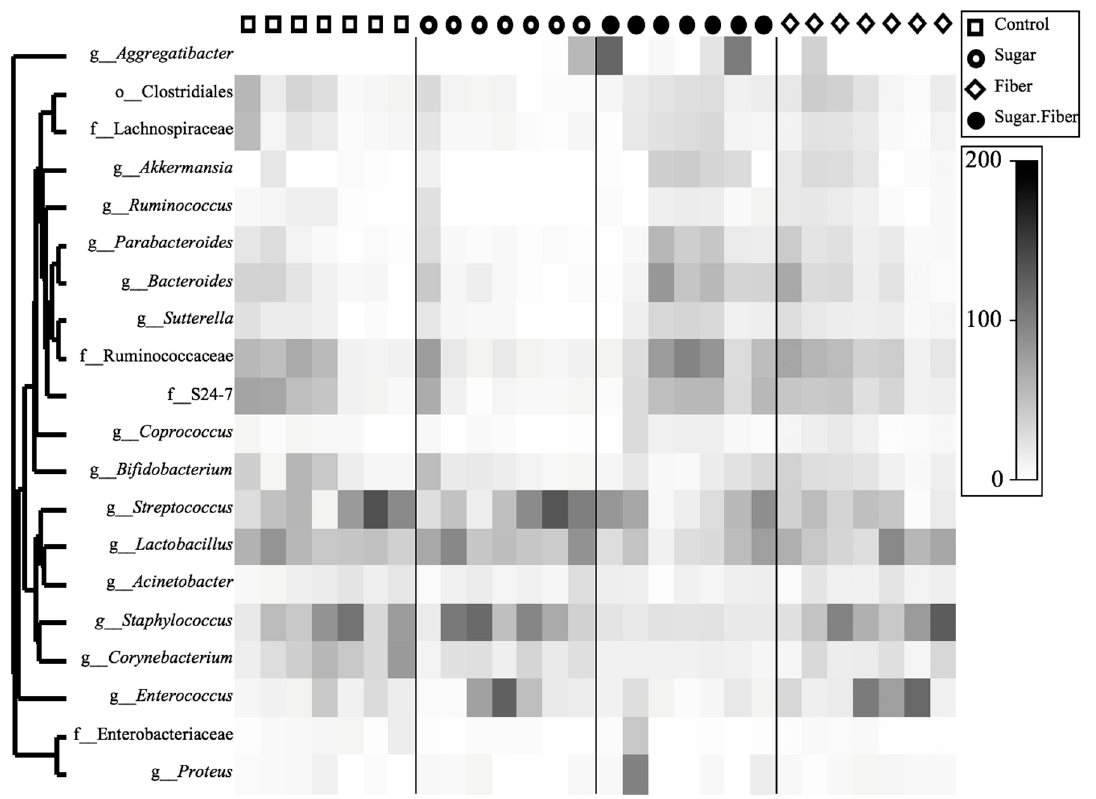
Figure 3. One-way clustered heatmap of genus-level abundance of the 20 most abundant microbial taxa. Data are square root-transformed and are based on sequence datasets rarefied to 25,000 sequences per sample.